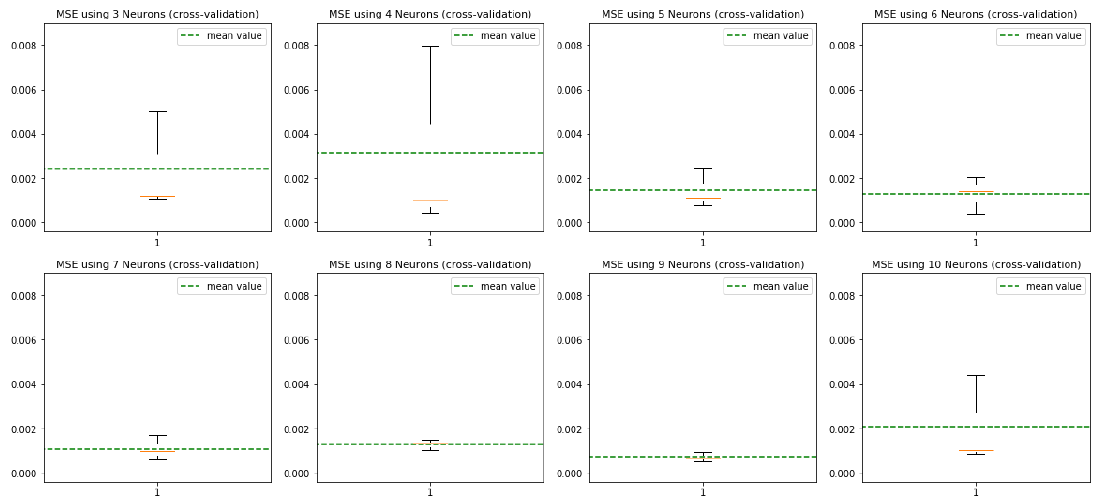
Figure 7. NN Model 1: number of nodes (one hidden layer).